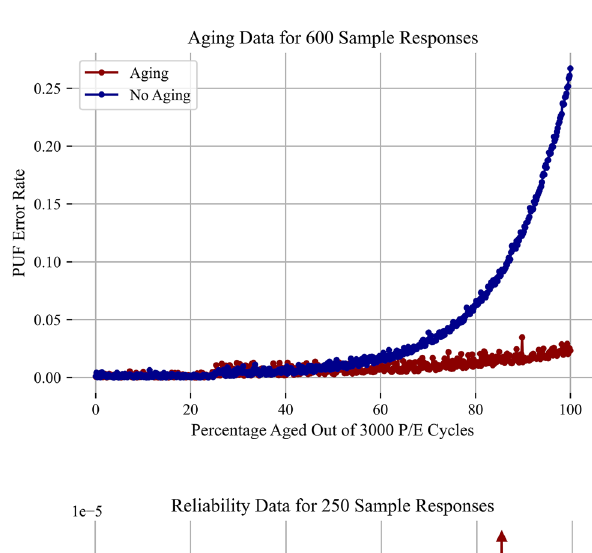
Fig. 11 Reliability of 250 responses at 50 % of life